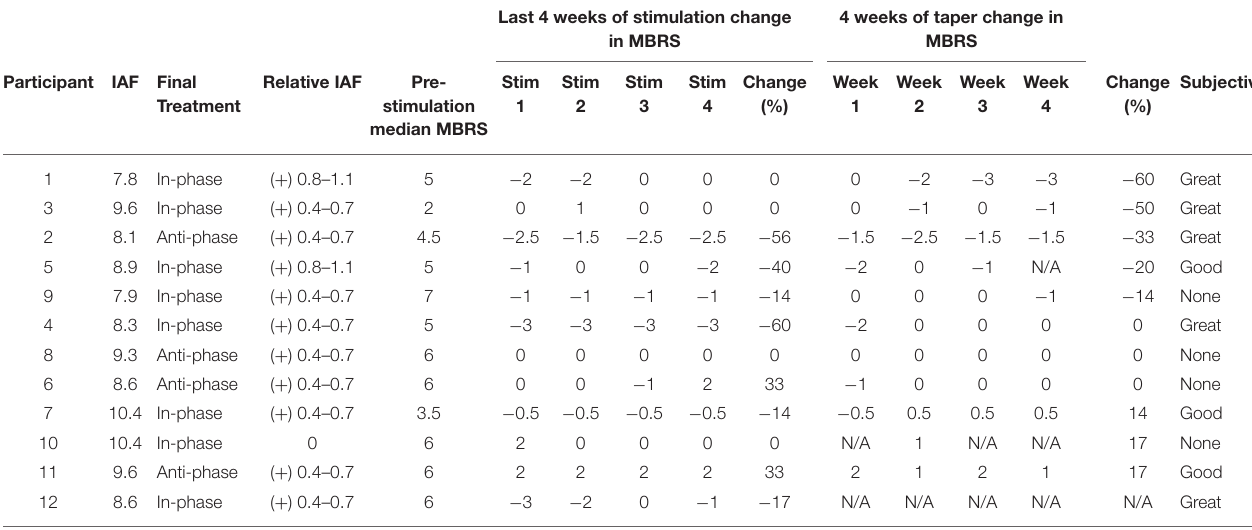
TABLE 3B | Mal de Débarquement balance rating scale (MBRS).